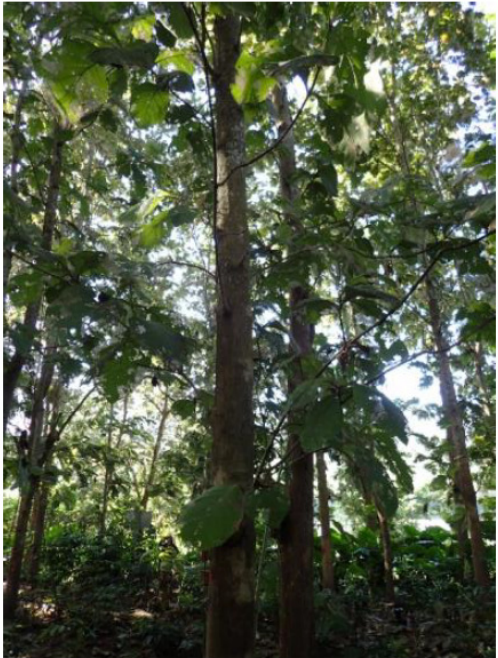
Figure 4. Photo of a teak tree with many epicormic shoots on its stems, taken from the riverside.